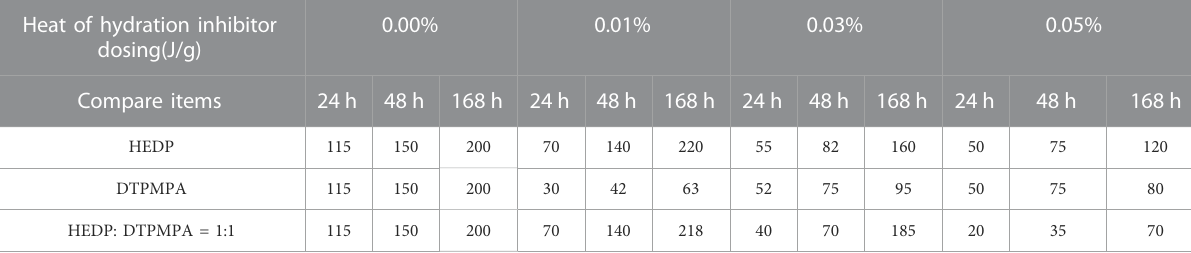
TABLE 6 Cumulative release data of C 3 S hydration heat over various time periods. Heat of hydration inhibitor 0.00% 0.01% 0.03% dosing(J/g)